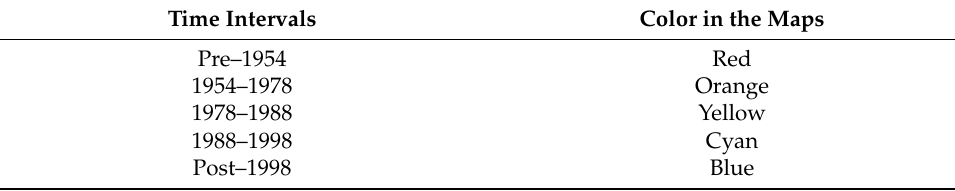
Table 1. The time intervals that were selected to sort out hard and soft protection interventions. Time Intervals Color in the